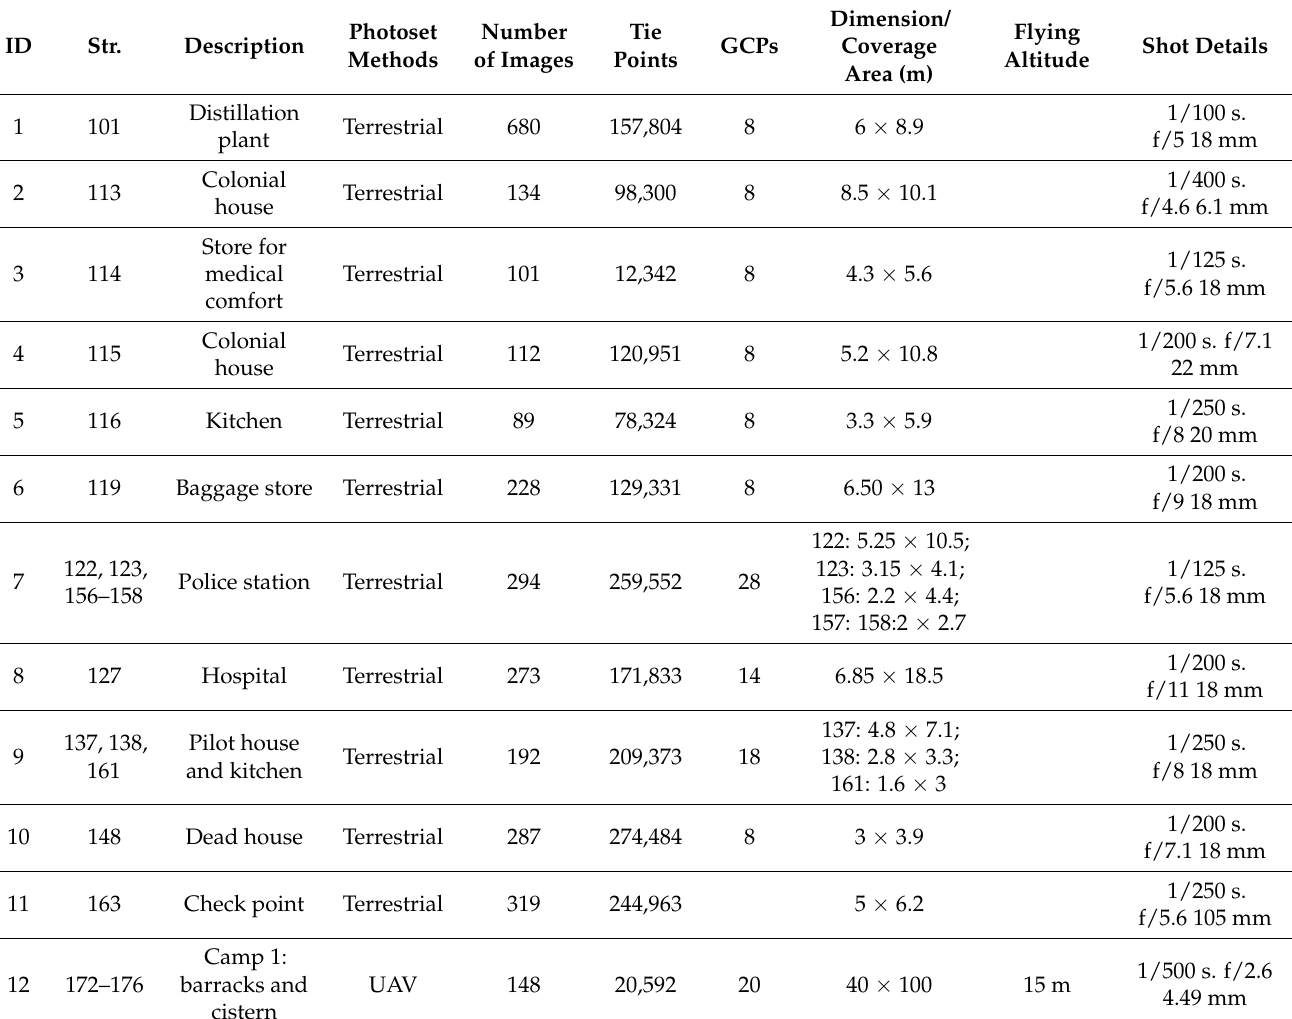
Table 2. Detail of UAV imagery and terrestrial